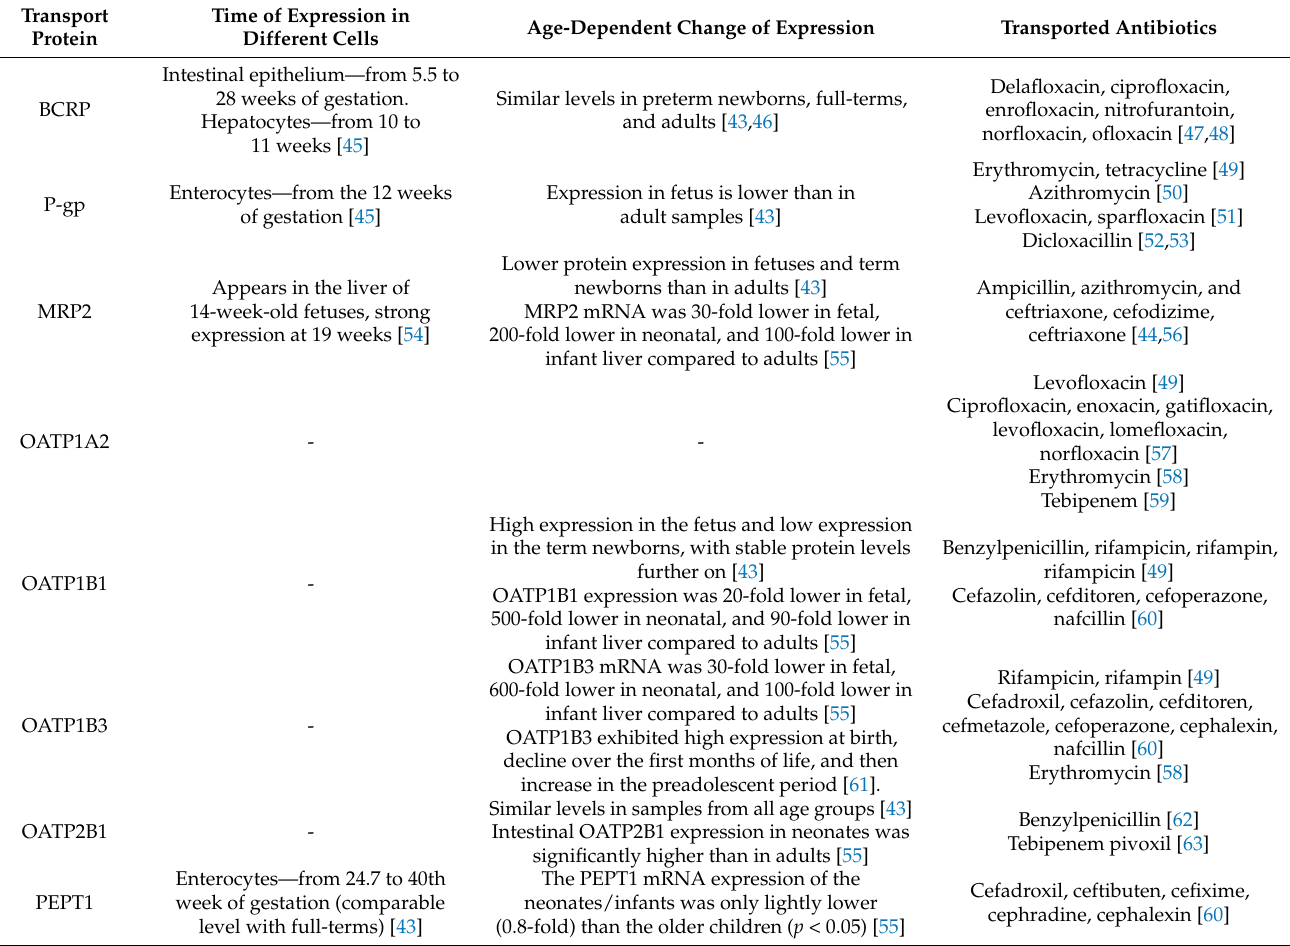
Table 1. Time of expression, age-associated changes, and antibiotic-substrates for the main intestinal transport